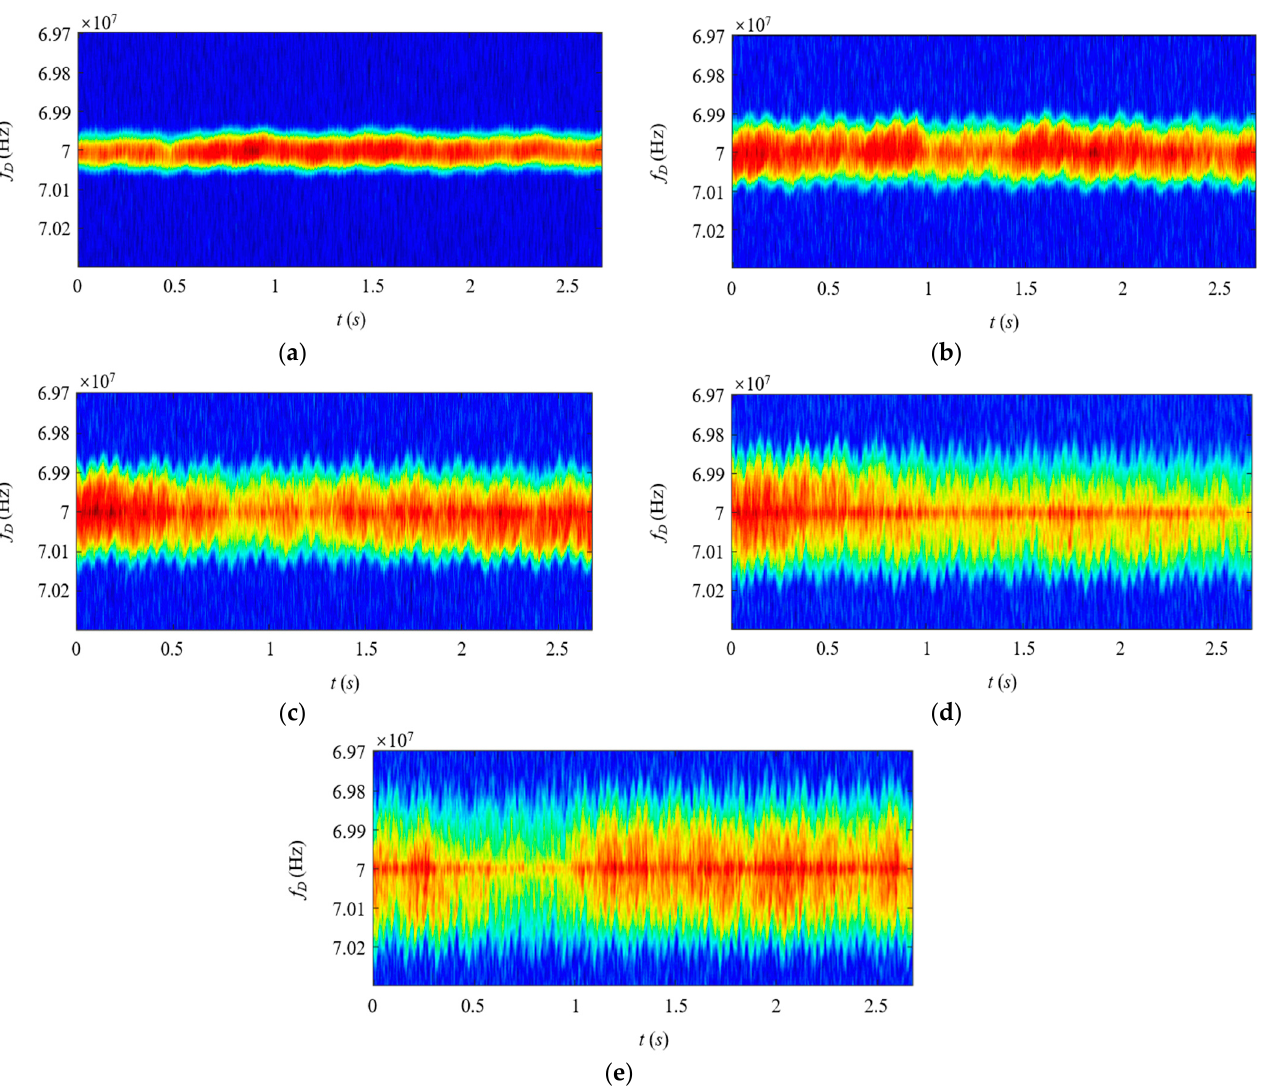
Figure 10. Time-frequency feature extraction experimental results of cube targets. ( a ) Spin rate = 1.4 Hz. ( b ) Spin rate = 2.5 Hz. ( c ) Spin rate = 3.8 Hz. ( d ) Spin rate = 5.0 Hz. ( e ) Spin rate = 6.4 Hz. Table 4. Cube target spin rate estimation results.